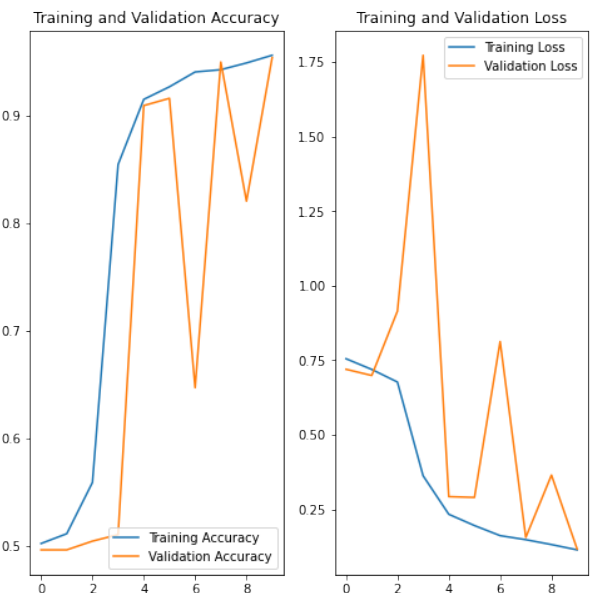
Figure 7. Validation accuracy and Training loss in Coco RGB(v2) Model 2 & 20